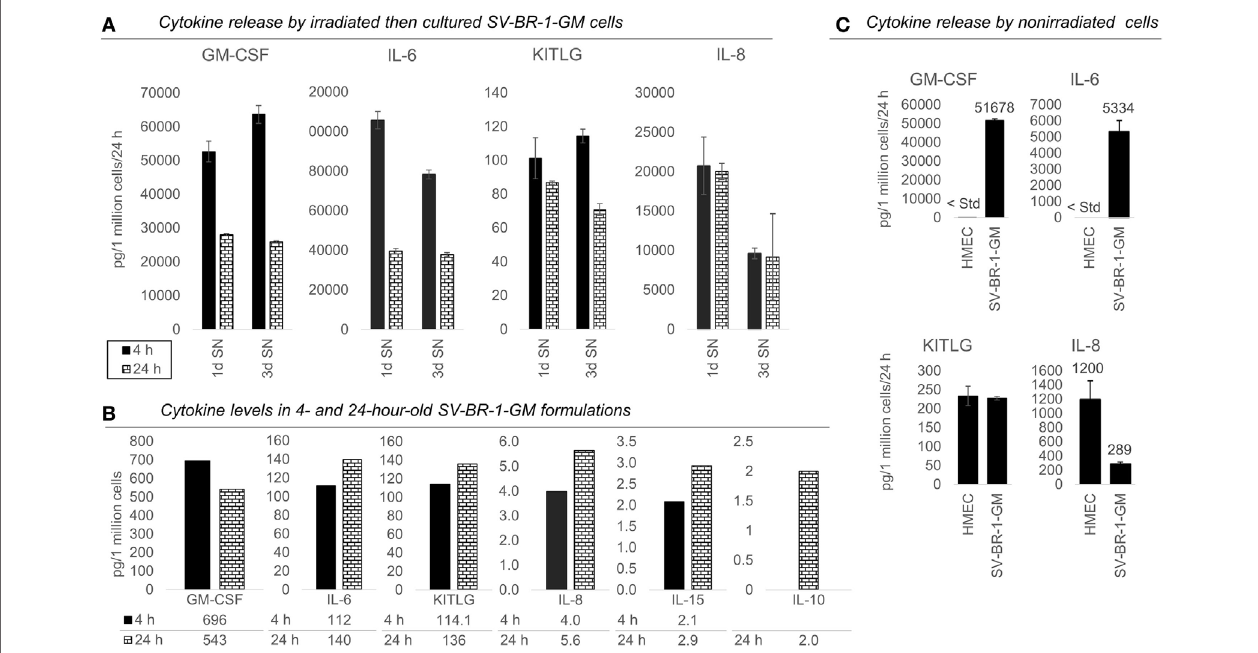
FigUre 4 | Cytokines secretion by irradiated and nonirradiated SV-BR-1-GM cells. (a) SV-BR-1-GM cells from 4- and 24-h-old clinical formulations were seeded in 6-well plates and cultured in full medium. Culture supernatants (SNs) were harvested after 1 day and 3 days of culturing then assessed for cytokine release. Note the substantially reduced levels of granulocyte–macrophage colony-stimulating factor (GM-CSF) and interleukin (IL)-6 for the 24 h compared to the 4 h old formulation. Values shown are arithmetic means from triplicate wells ± SDs, expressed as pg cytokine/1 million viable cells (at time of seeding)/24 h. For KITLG, one of the 24 h, 3d wells was excluded as the obtained cytokine levels were substantially higher than those of the other two wells. For IL-8, ELISAs for the 4 and 24 h samples were conducted on different days. (B) Cytokine levels in the Lactated Ringer’s solution (LRS) fractions of the formulations from (a) . For IL-10, data are only shown for the 24 h sample. Values shown are arithmetic means from technical duplicates, expressed as pg cytokine/1 million total cells. (c) Nonirradiated human mammary epithelial cells (HMECs) and SV-BR-1-GM cells were cultured in parallel then assessed for cytokine release 24 h after replacing the culture medium. Note that the IL-6 and IL-8 levels from the nonirradiated SV-BR-1-GM cells shown here are substantially lower than those from the irradiated SV-BR-1-GM cells shown in (a) . Values shown are arithmetic means from triplicate wells ± SDs, expressed as pg cytokine/1 million viable cells/24 h, whereby cell viability was determined on the day of medium change (initiation of cytokine accumulation) from cells cultured in parallel